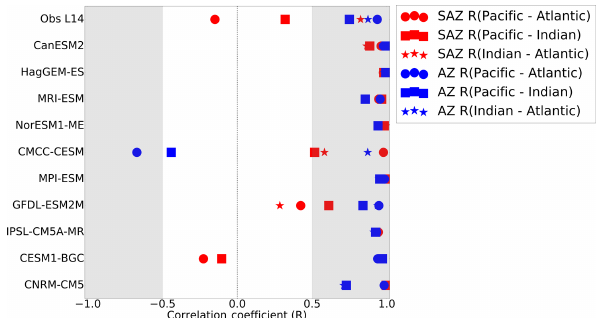
Figure 4. The correlation coefficients ( R ) of basin–basin seasonal cycles of F CO 2 for observations (Landschützer et al., 2014) and 10 CMIP5 models in the three basins of the Southern Ocean, i.e., Pa- cific, Atlantic and Indian